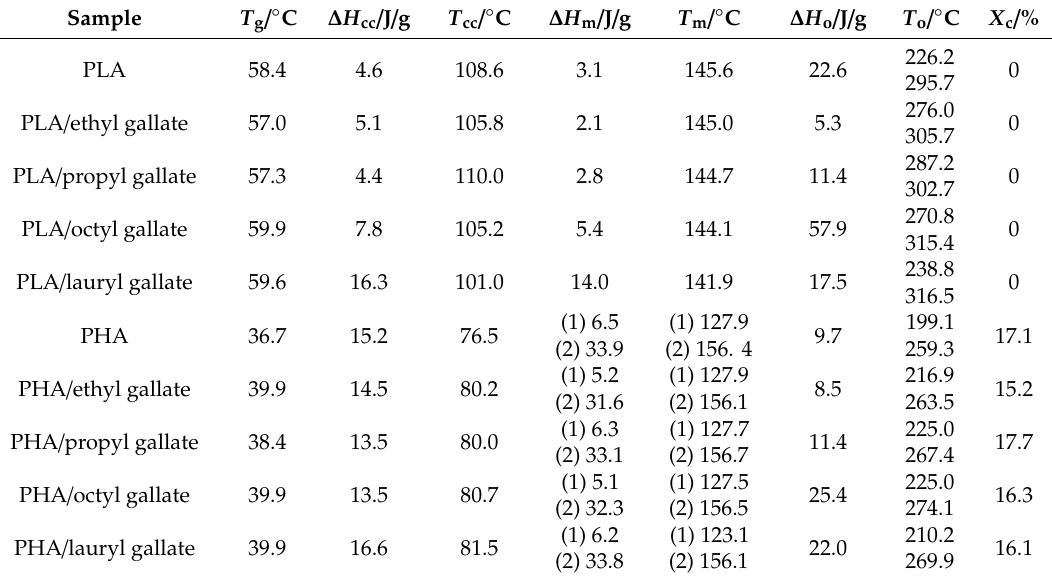
Table 2. DSC analysis of the PLA and PHA samples containing